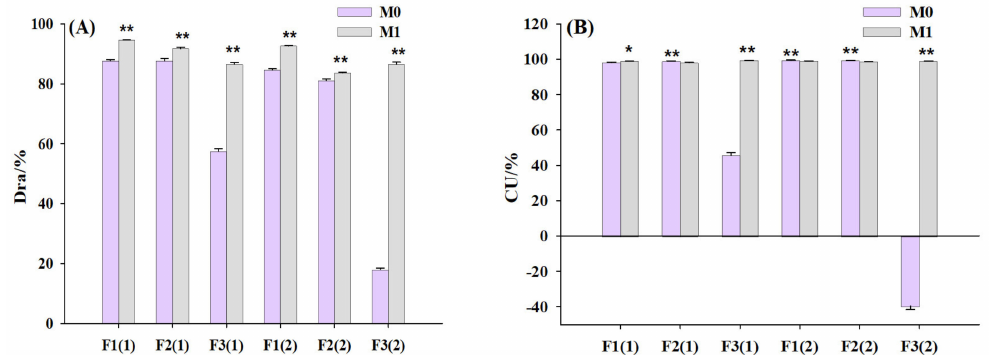
Figure 1. Dra ( A ) and CU ( B ) of magnetization treatments and under three fertilization levels of two planting seasons. (1) Means the first season, (2) means the second season; * indicates p < 0.05, ** indicates p < 0.01.